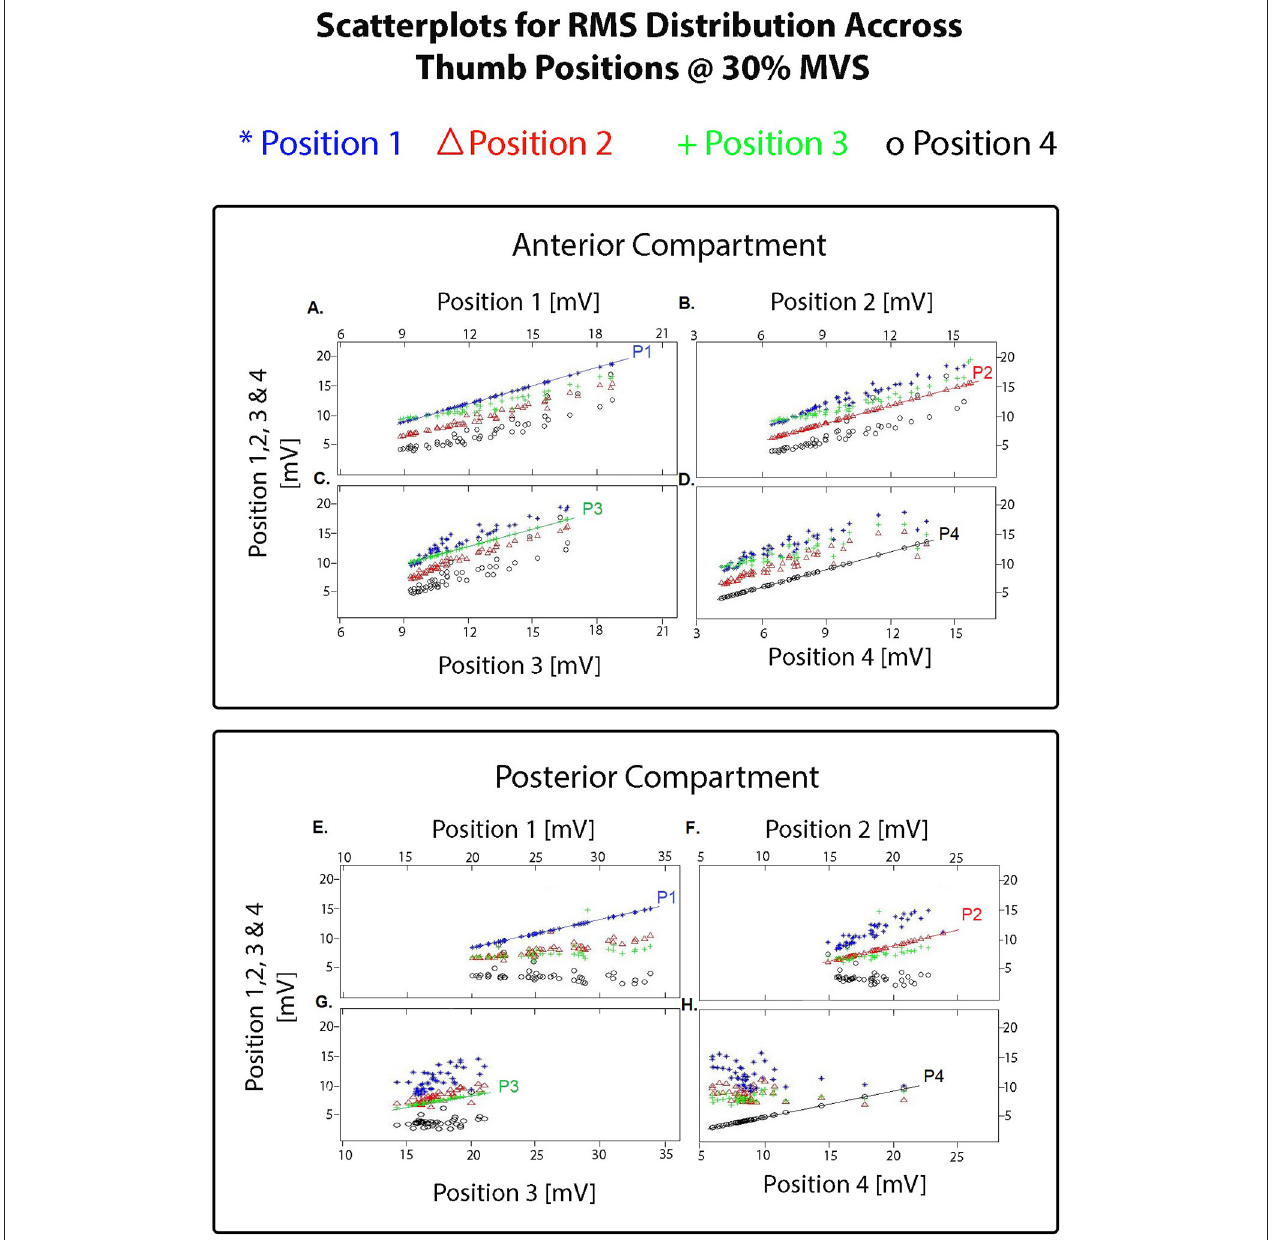
FIGURE 5 | Resulting pair-wise scatterplots obtained using the Matlab Classification Learner toolbox (R2015a) on the averaged 300ms overlapping windows of RMS vectors separated by thumb posture and by grid (totaling 7,680 vectors per grid). Each scatterplot shows the resulting clusters for each position as the comparator (i.e., P1 compared with P1 to 4; P2 compared with P1 to 4; and so on). For the electrode grid placed on the anterior compartment: (A) shows the resulting clusters highlighting the amplitude variation between position 1 of the thumb compared with position 1 (reference line on the graph labeled as P1), position 2, 3, and 4; (B) shows the resulting clusters highlighting the amplitude variation between position 2 of the thumb compared with position 2 (reference line on the graph labeled as P2), position 1, 3, and 4; (C) shows the resulting clusters highlighting the amplitude variation between position 3 of the thumb compared with position 3 (reference line on the graph labeled as P3), position 1,2, and 4; (D) shows the resulting clusters highlighting the amplitude variation between position 4 of the thumb compared with position 4 (reference line on the graph labeled as P1), position 1, 2, and 3. Similarly for the electrode grid placed on the posterior compartment with the posture comparison on (E–H) . As shown in these scatterplots and on the iso-potential maps on Figure 4 , changes between the different thumb postures were only detected in amplitude.